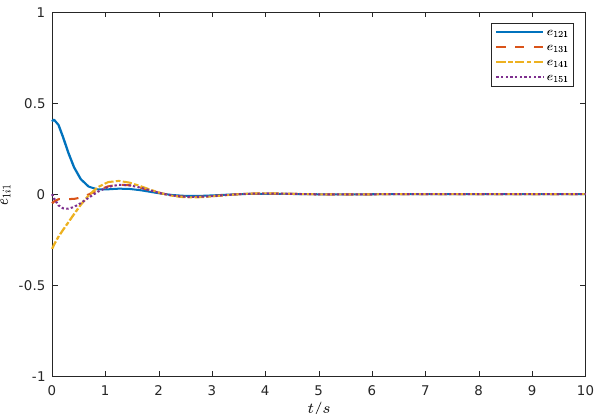
Figure 3. The state response errors e 1 i 1 under the initial state x 0 and the control input u i .